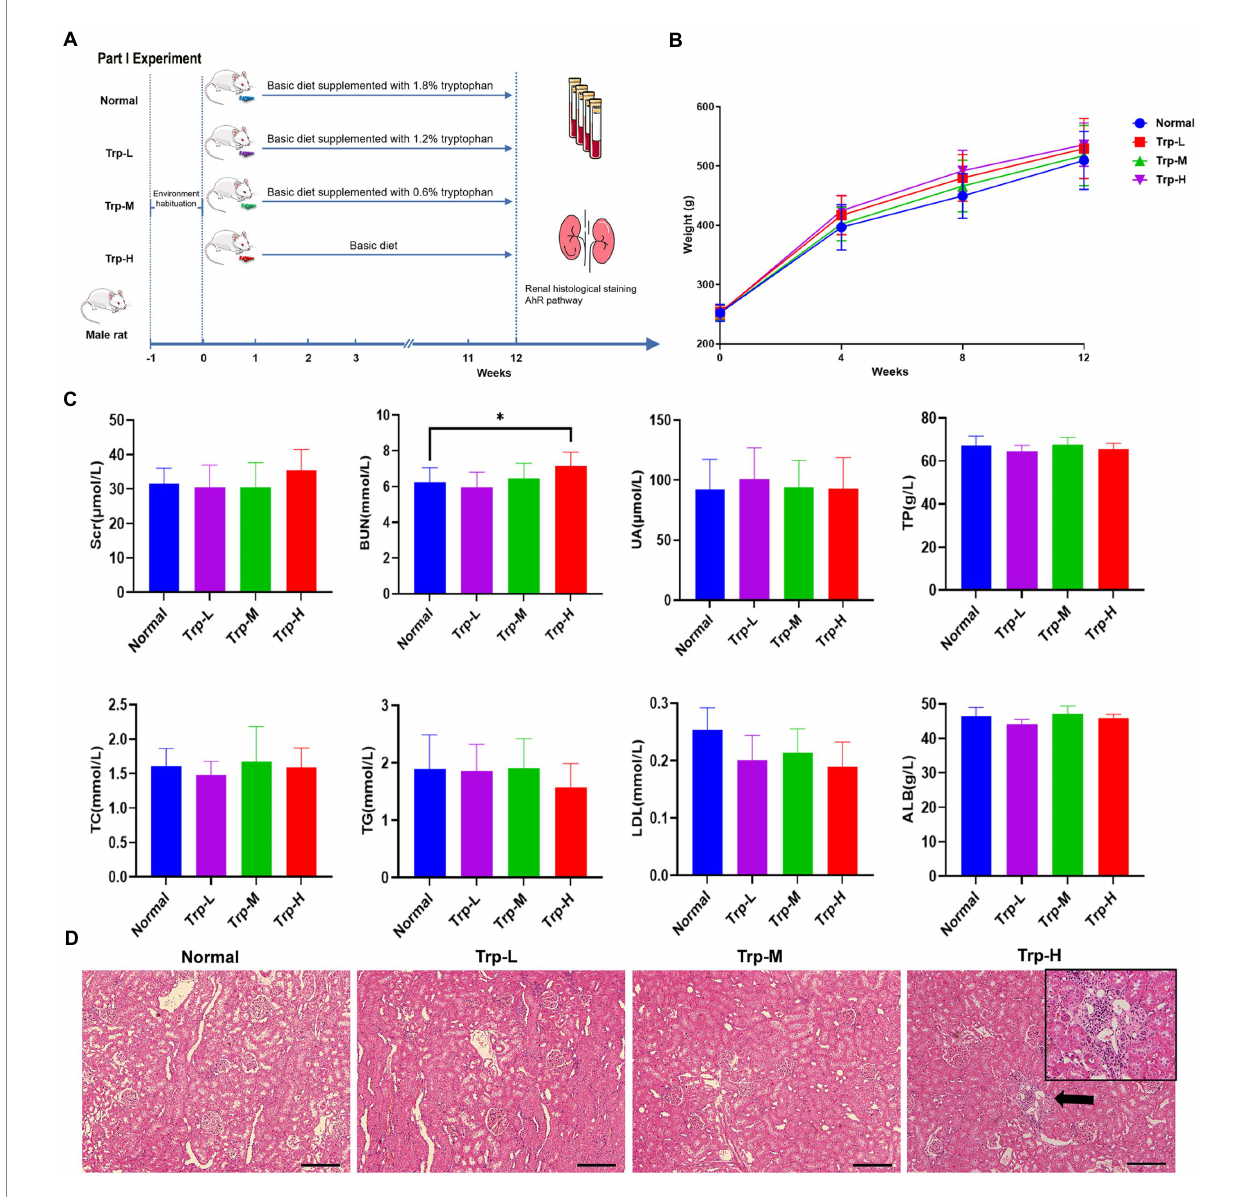
FIGURE 1 Dietary tryptophan induced kidney injury phenotypes in healthy rats. (A) Schedule of Part I experiment. (B) Body weight. (C) Serum creatinine, blood urea nitrogen, uric acid, total protein, total cholesterol, triglyceride, low density lipoprotein, albumin. (D) Hematoxylin–eosin staining of kidney tissue (100×). The data are presented as the mean + standard deviation, n = 10 rats per group (* p <